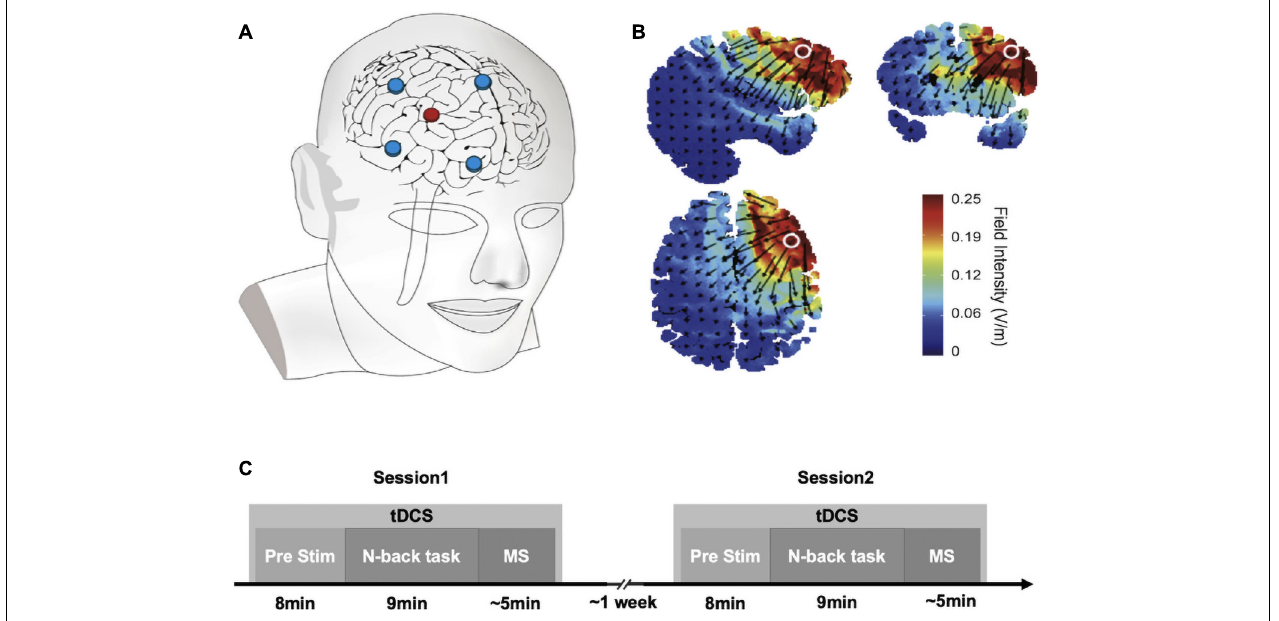
FIGURE 1 | Transcranial direct current stimulation (tDCS) protocols and electric field simulation. (A) Electrode placements. (B) Electric field simulations. Arrows point in the direction of current flow, and arrow length indicates current flow intensity. (C) Experimental